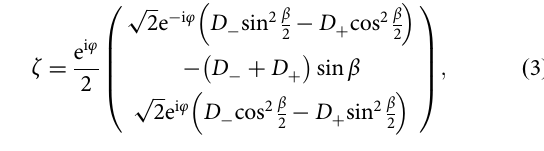
the polar phase ð 0 ; e i φ ; 0 Þ T . These features are clearly seen in Fig. 1b – d. Creation of this vortex state using magnetic phase exchange is one of the principal results of the present study.